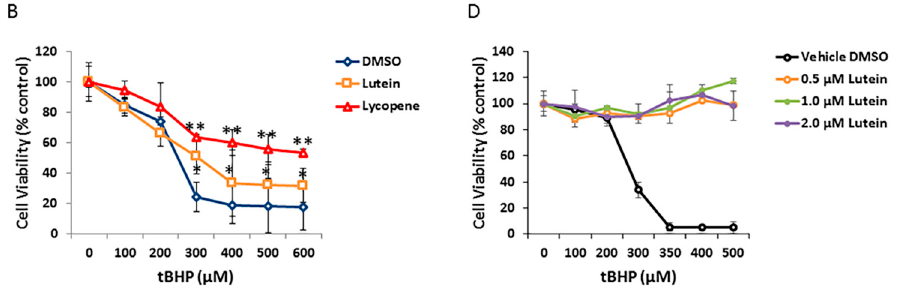
Figure 6. Protective effects of lutein and lycopene against oxidative stress-induced cell death. ( A ) ARPE-19 cells pretreated with vehicle control and 1 µ M concentration of each carotenoids were exposed to different concentrations of tert -butyl hydroperoxide (tBHP). Cell survival was evaluated by MTT assay. ( B ) Analysis of lutein and lycopene protective effect on RPE cells under different tBHP concentrations. Cell viability was normalized to non-treated controls and was expressed as percentage of control. Data are shown as means ± SD of three different experiments ( n = 3). *, p < 0.05; **, p < 0.001. ( C ) Comparison of ARPE-19 cell survival upon co-treatment of lutein and tBHP. ( D ) Analysis of protective effect of co-exposure of lutein and tBHP on RPE cells.